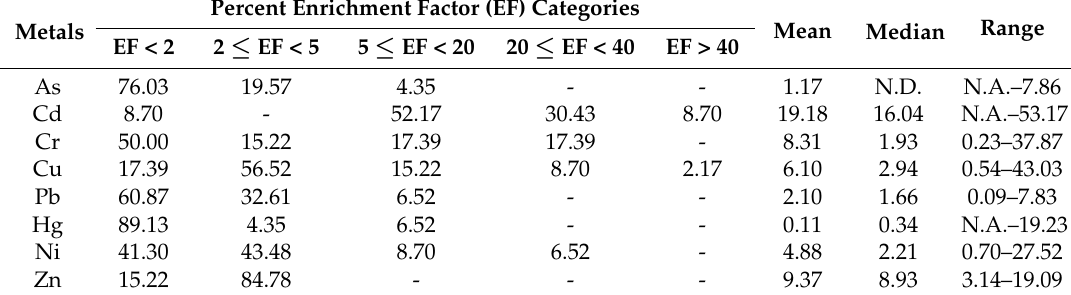
Table 3. Description of enrichment factor (%) in each pollution category for trace metals in Awash River